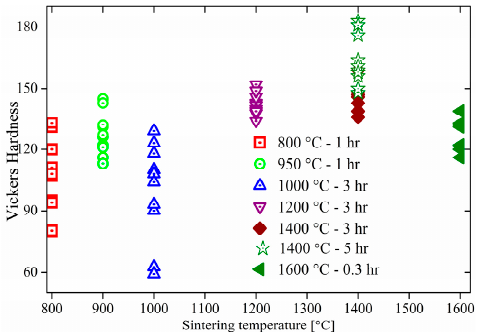
Figure 6. The hardness of sintered EuS compacts.